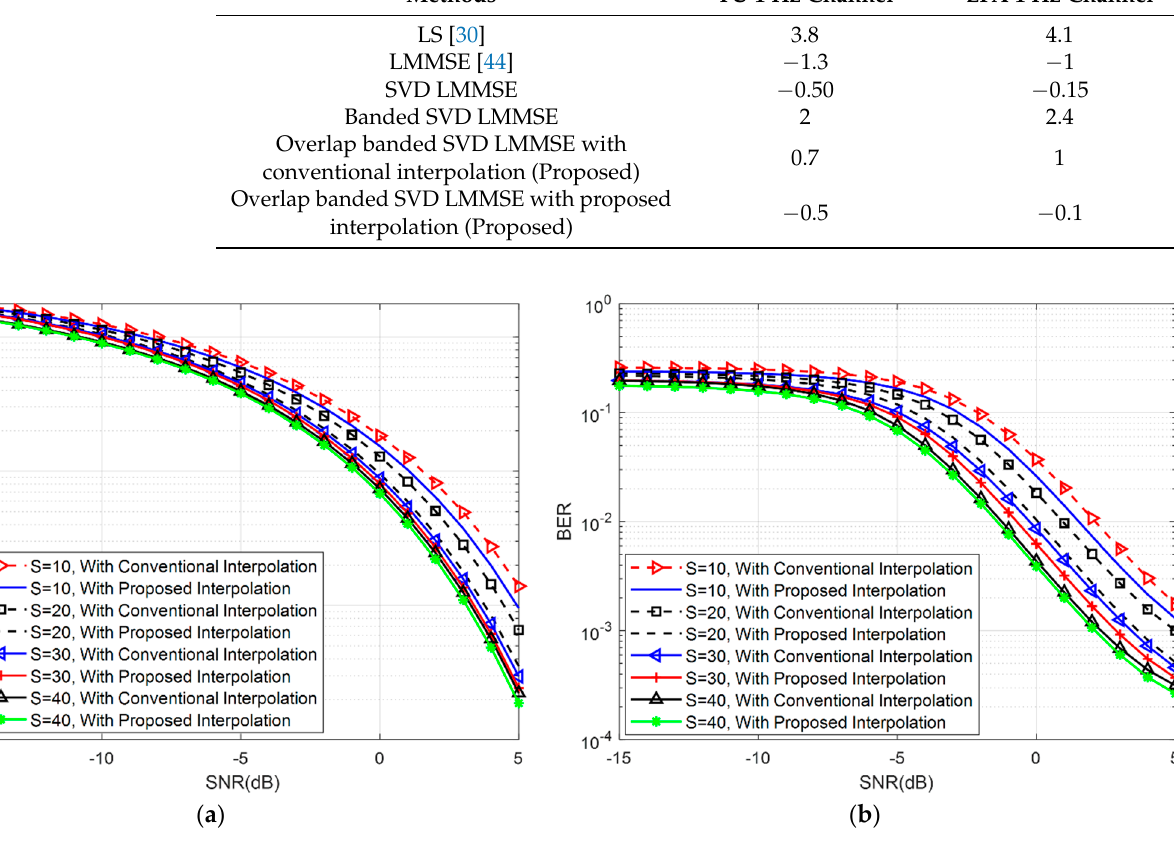
Figure 12. Bit error rate (BER) comparison of the proposed technique with the conventional and proposed interpolation methods for different subvector values: ( a ) TU 1 Hz; ( b ) EPA 1 Hz.